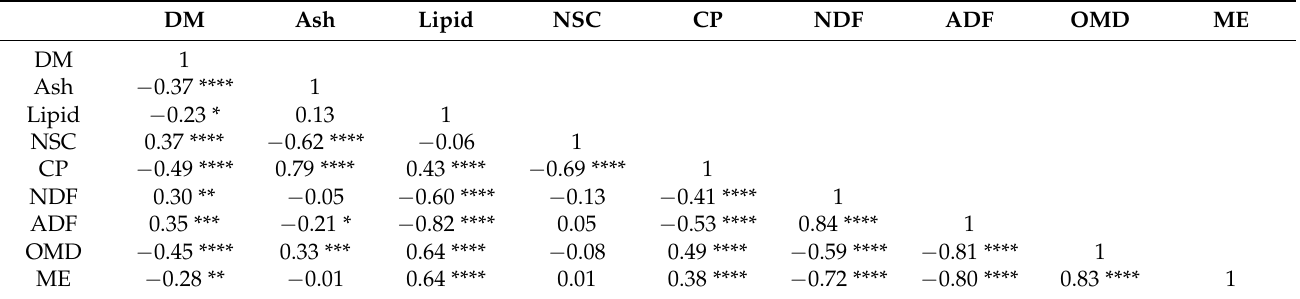
Table 4. The correlation matrix for pasture dry matter (DM) and herbage quality nutrients ( n = 112).